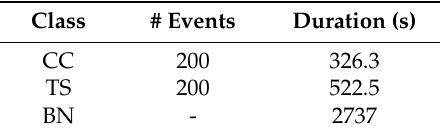
Table 2. Details on the composition of the